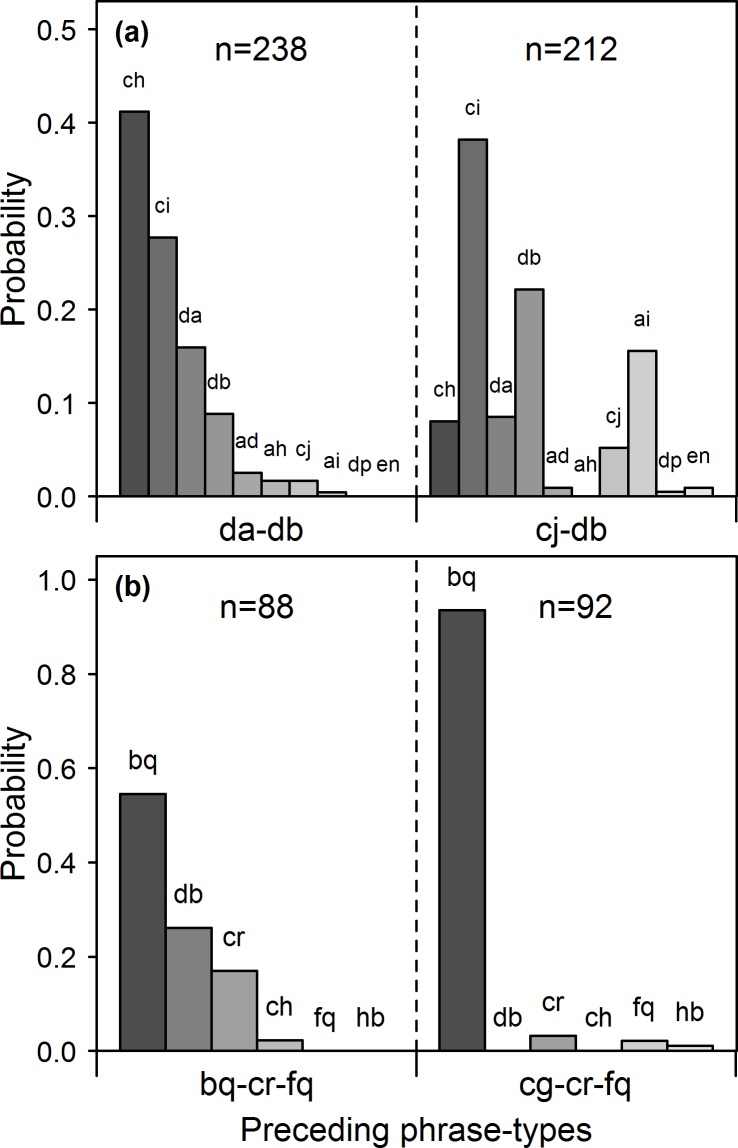
A representation of second-order (a) and third-order (b) dependencies in the songs of the bird ‘AGBk’. Bars represent the probability of observing a given phrase type given the identity of the preceding phrase types indicated below each graph. a) ultimate phrase type was db, and the probability distribution of upcoming phrase types changed depending on whether the penultimate phrase type was da or cj (Chi-square test for independence, Χ2(9, N = 450) = 116.94, p<0.0001). b) penultimate and ultimate phrase types were cr and fq in both cases, and the probability distribution differed with the identity of the antepenultimate phrase type, whether bq or cg (Fisher’s exact test, p<0.0001). Sample sizes indicate the number of observations upon which the probabilities were conditioned.